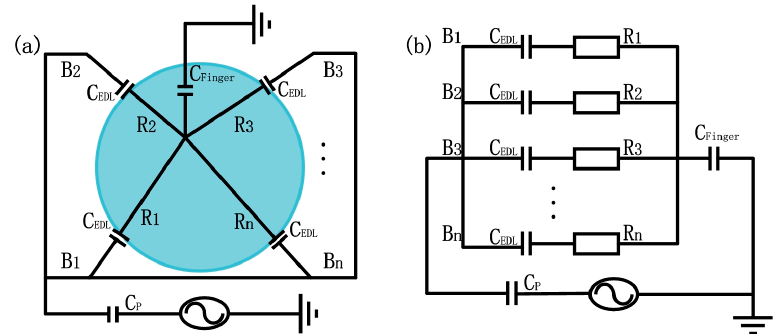
Figure 4. The sensing model ( a ) and electrical circuit diagram ( b ) of an ionic touch panel. C EDL represents capacitance caused by finger touch on the panel, B1-Bn indicates sections of the panel divided by the finger touch, R and C EDL are the resistance and capacitor of an electrical double layer for each section, and C P is the parasitic capacitance between the ionic gel panel and the